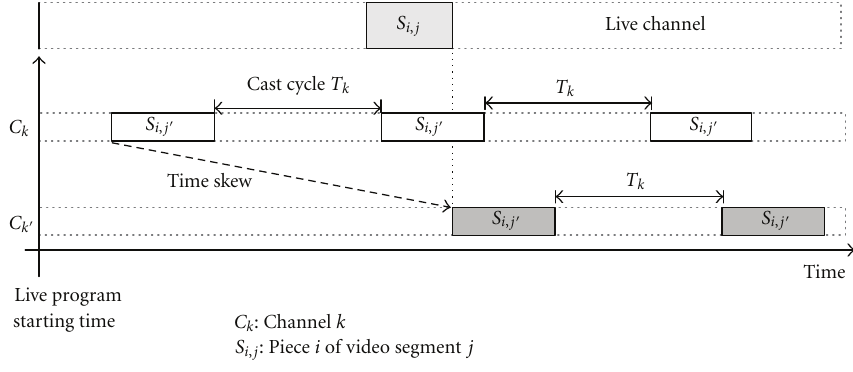
Figure 3: An illustration of time